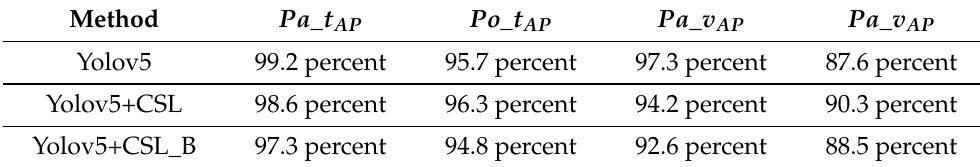
Table 4. Relative angle